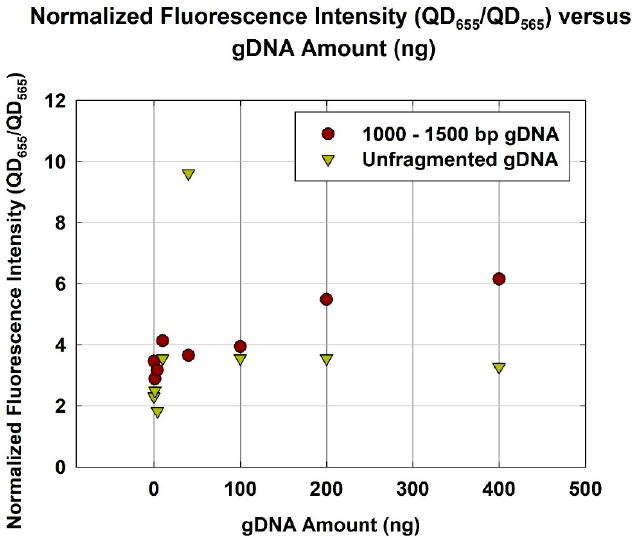
Figure 5. Normalized fluorescence intensity (QD 655 /QD 565 ) versus gDNA amount (ng) for optimum size range (1000–1500 bp) and unfragmented